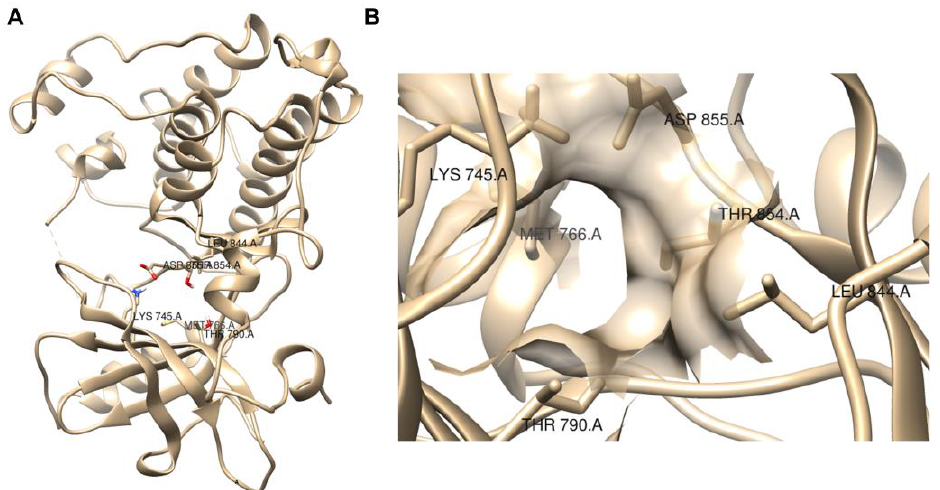
Figure 14. Visualization of EGFR protein (PDB, ID 3W2S) with UCSF Chimera [58]. ( A ) Full view; ( B ) binding active pocket region [101,102].